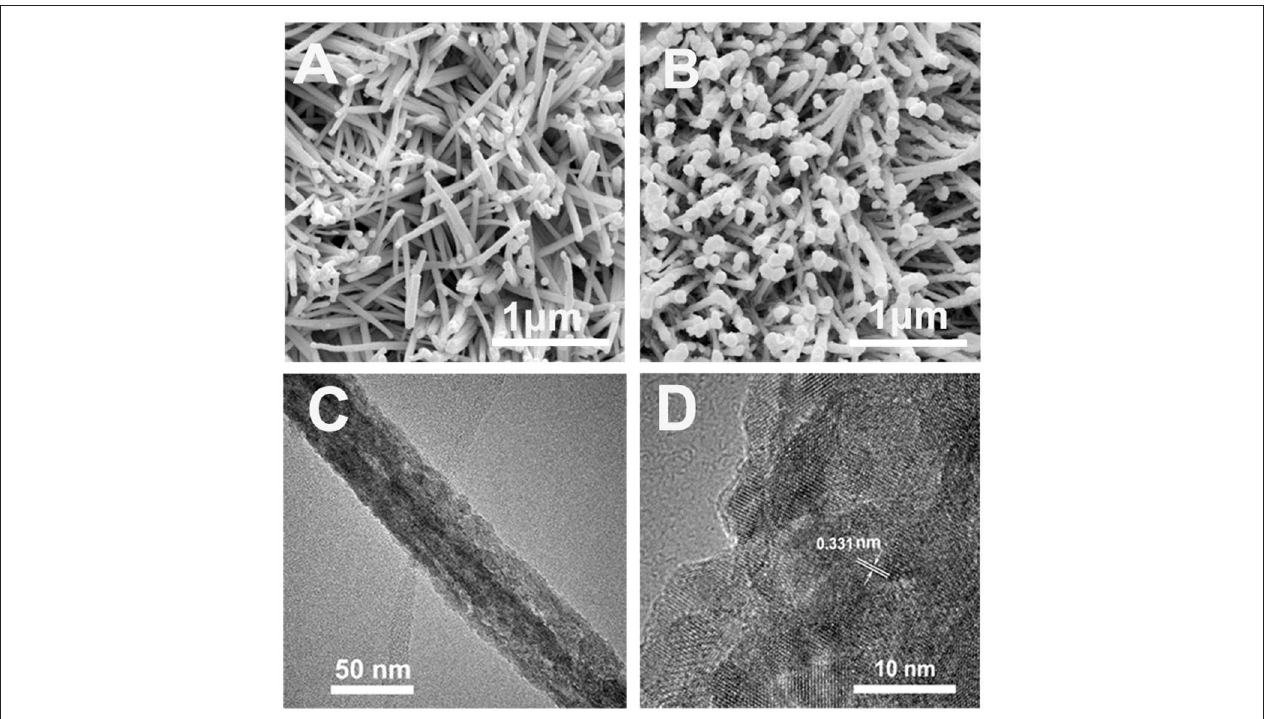
FIGURE 2 | (A) SEM pattern of precursor (FeCoNi-FeOOH). (B) SEM pattern of FeCoNiS-FeO x . (C) TEM pattern of FeCoNiS-FeO x . (D) HRTEM pattern of FeCoNiS-FeO x